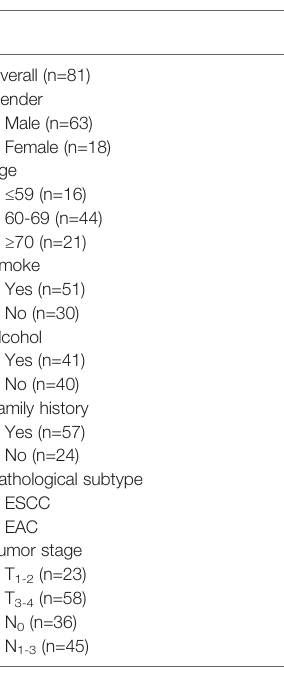
TABLE 2 | P16 methylation in GSM